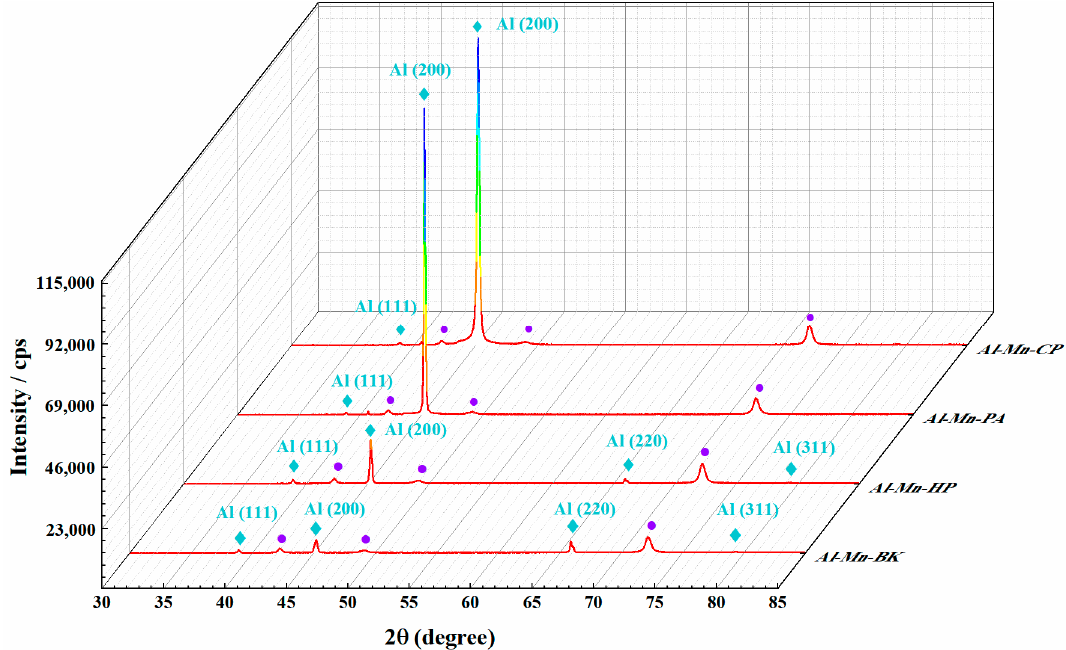
Figure 4. XRD patterns obtained for the Al-Mn-BK, Al-Mn-HP, Al-Mn-PA, and Al-Mn-CP coatings. Diffraction peaks of the Al and Cu substrates were denoted by ♦ and •, respectively.